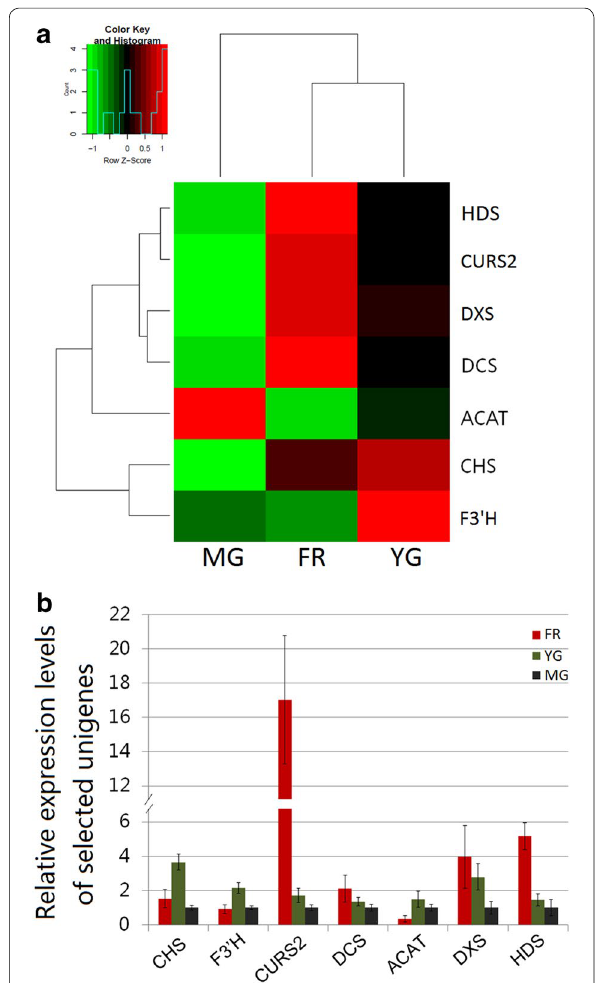
Fig. 6 Heat map of the expression levels of seven ginger unigenes as determined by the fragments per kilobase of exon per million frag- ments mapped (FPKM) ( a ) and qRT-PCR analysis ( b